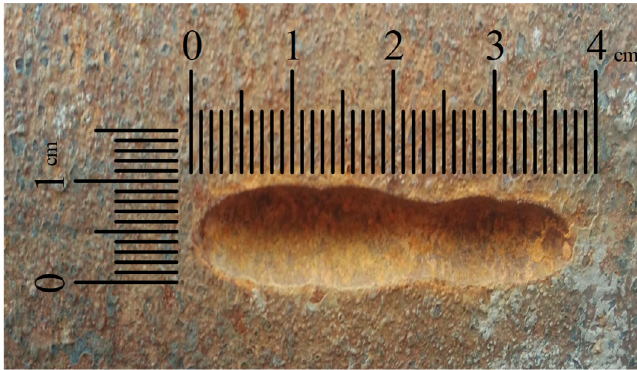
Figure 8. The picture of the non ‐ standard defect.